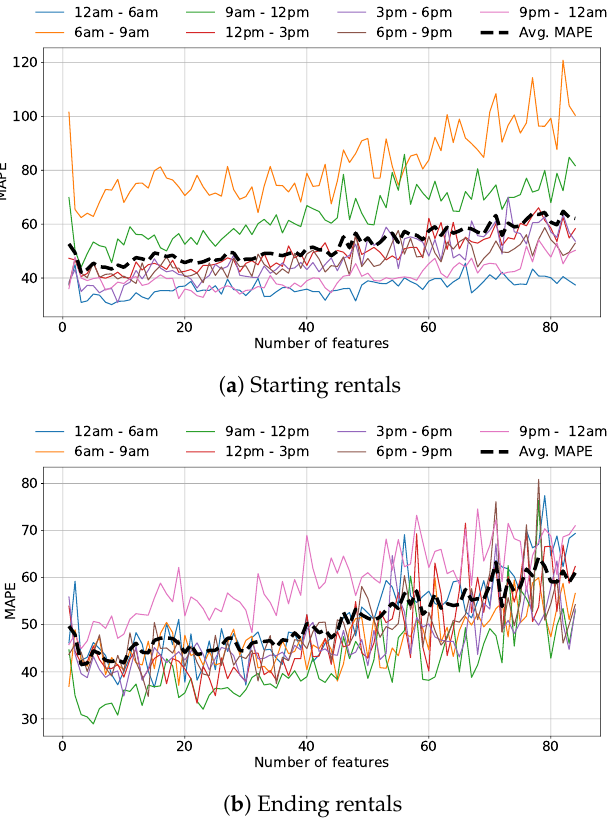
Figure 12. Spatial prediction—MAPE in the different time bins by selecting the most relevant features in